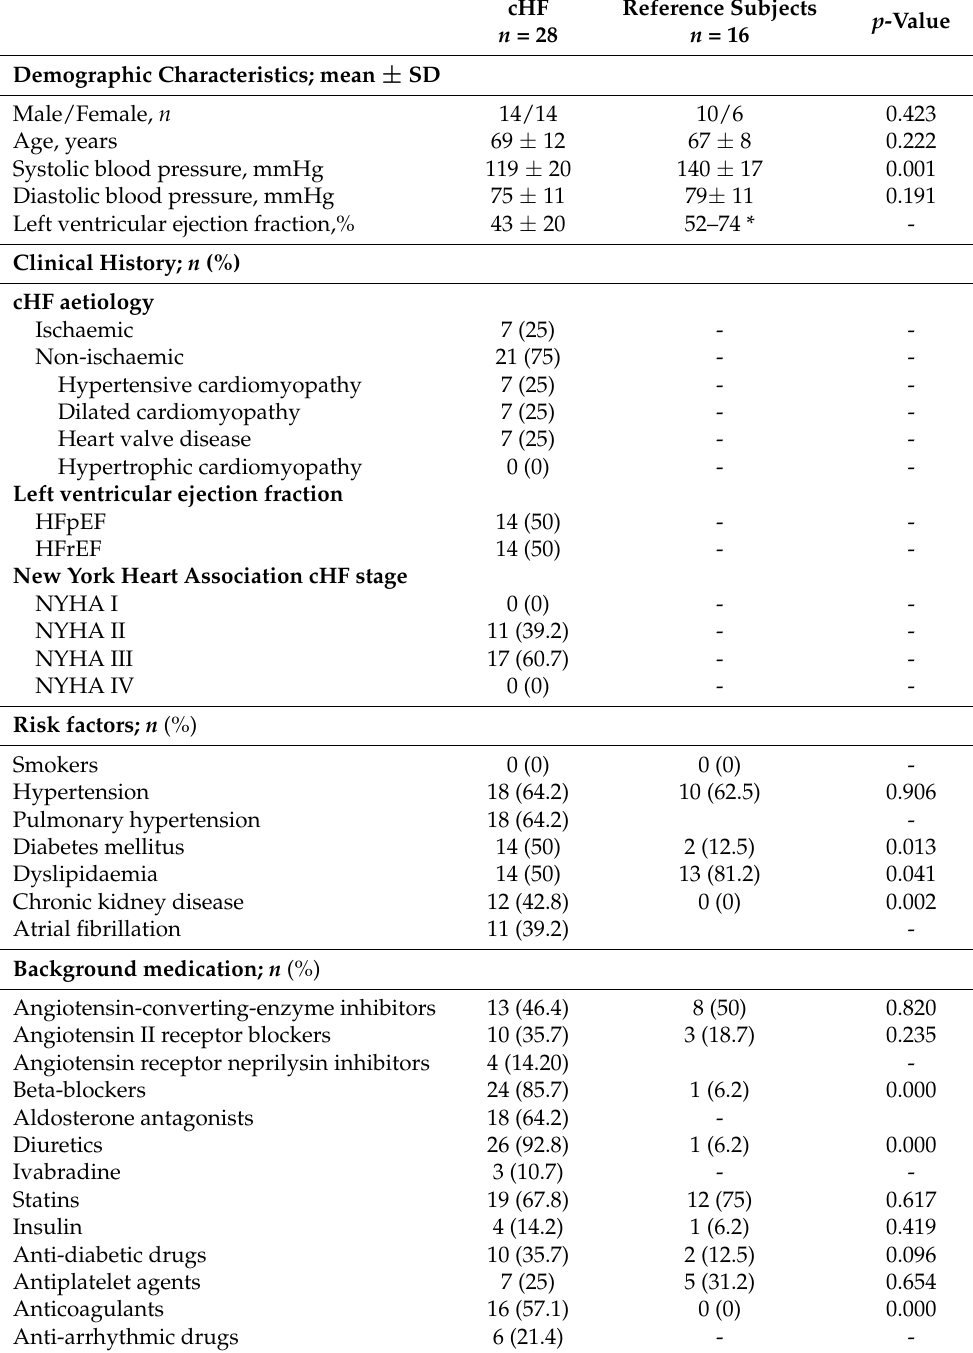
Table 4. Baseline characteristics of cHF patients and reference subjects in the miRNA